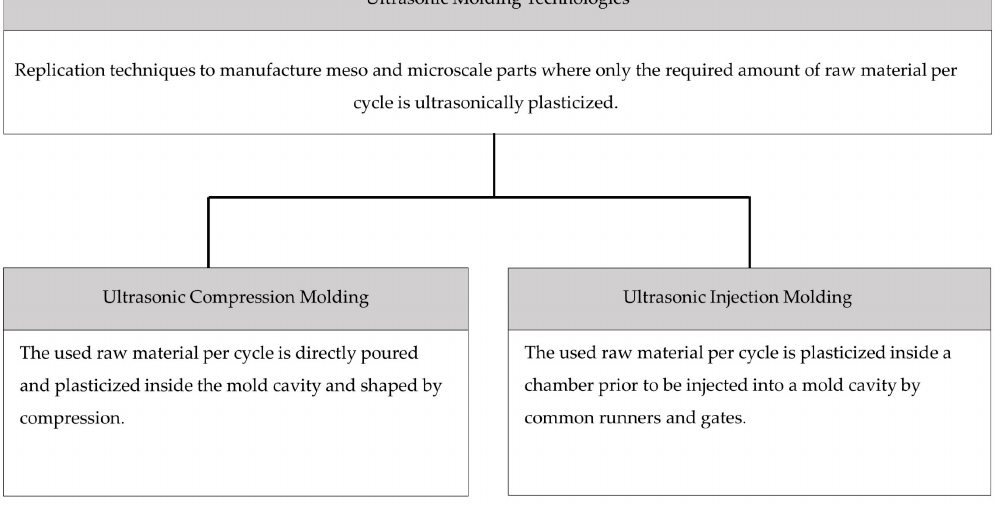
Figure 2. Summary ultrasonic molding technologies definitions.